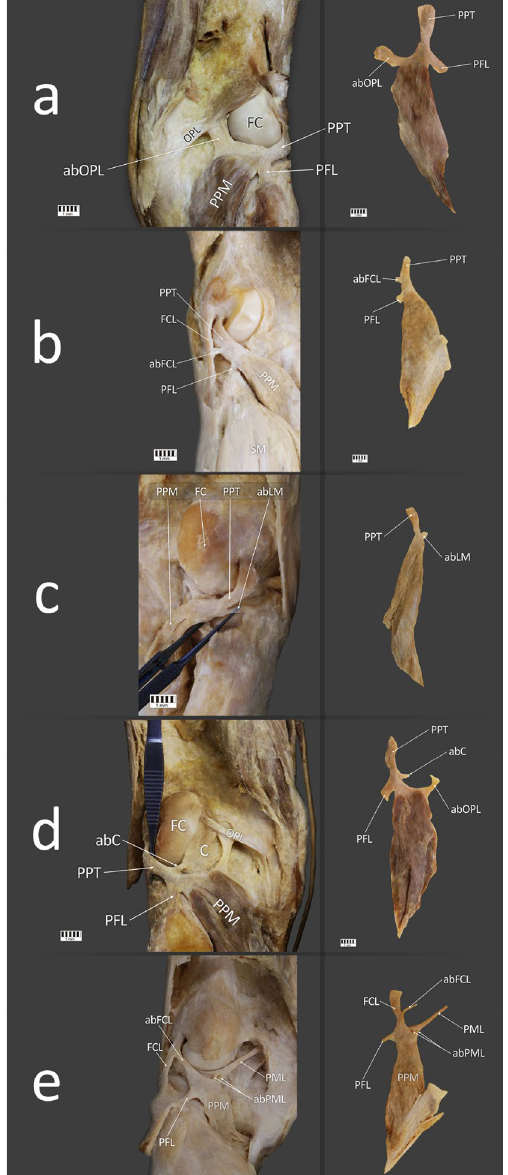
Figure 2. Type II of the popliteus tendon attachment. ( a ) LEFT—Posterior view of the right knee joint with Type IIa of the popliteus tendon. RIGHT—Isolated popliteus muscle with Type IIa of the popliteus tendon. ( b ) LEFT—Posterior view of the left knee joint with Type IIb of the popliteus tendon. RIGHT—Isolated popliteus muscle with Type IIb of the popliteus tendon. ( c ) LEFT—Posterior view of the right knee joint with Type IIc of the popliteus tendon. RIGHT—Isolated popliteus muscle with Type IIc of the popliteus tendon. ( d ) LEFT— Posterior view of the left knee joint with Type IId of the popliteus tendon. RIGHT—Isolated popliteus muscle with Type IId of the popliteus tendon. ( e ) LEFT—Posterior view of the left knee joint with Type IIe of the popliteus tendon. RIGHT—Isolated popliteus muscle with Type IIe of the popliteus tendon. PFL—popliteo- fibular ligament, PPT—popliteus tendon, PPM—popliteus muscle, OPL—oblique popliteal ligament, abOPL— accessory band to the oblique popliteal ligament, FC—femoral condyle, FCL—fibular collateral ligament, abFCL—accessory band to the fibular collateral ligament, SM—soleus muscle, abLM—accessory band to the lateral meniscus, C—the knee joint capsule, abC—accessory band to the knee joint capsule, PML—posterior meniscofemoral ligament, abPML—accessory band to the posterior meniscofemoral ligament. The Fig. 2 was taken with Canon EOS 6D camera with Canon EF 100 mm f/2.8 L Macro Is USM, and the signatures were made in Corel DRAW 12 (https:// www. corel draw. com/ pl/ pages/ corel draw-